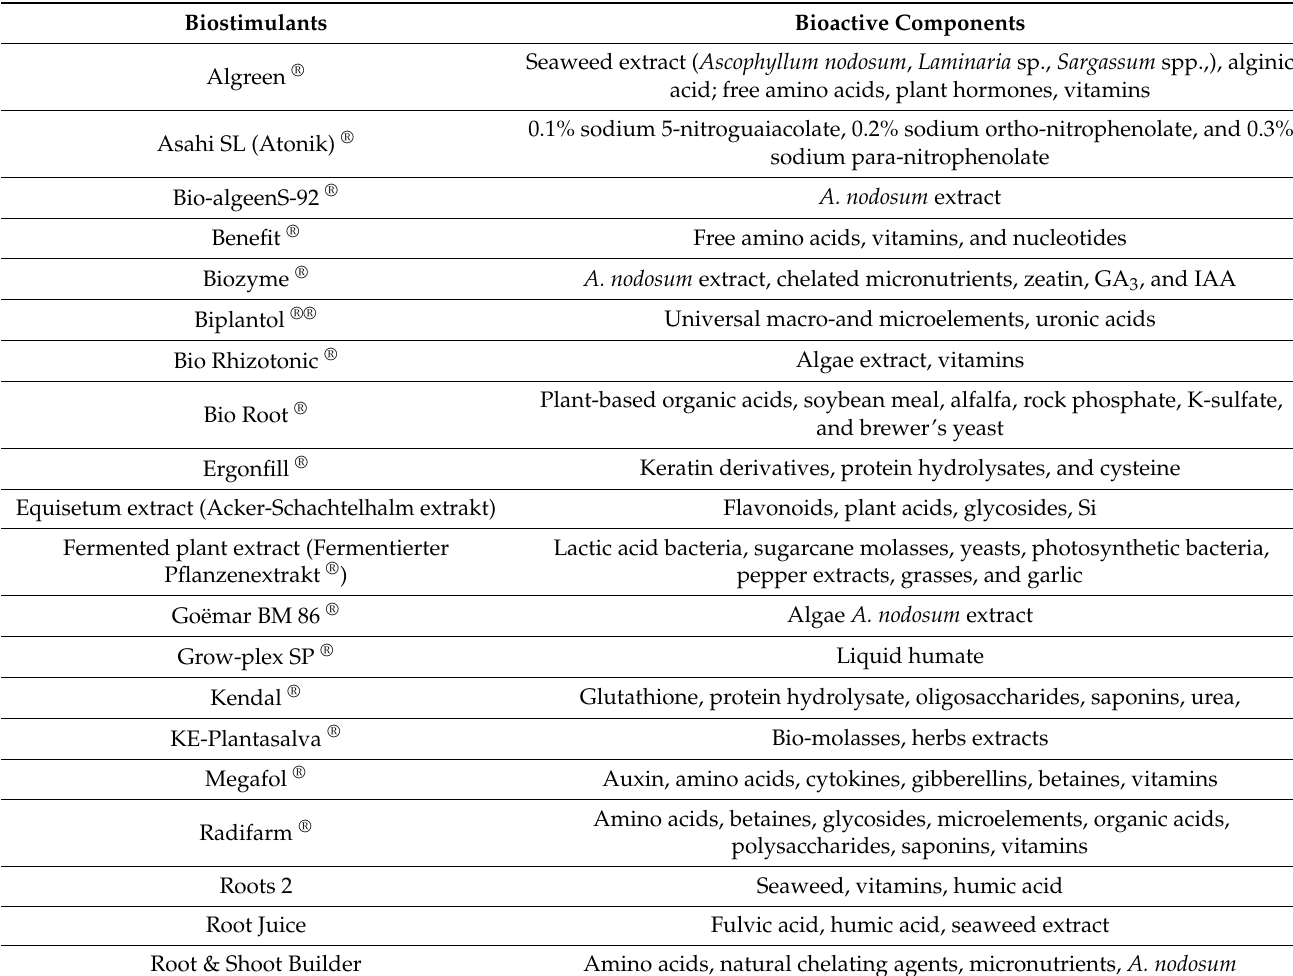
Table 1. The commercially available biostimulants with functional active components [30].